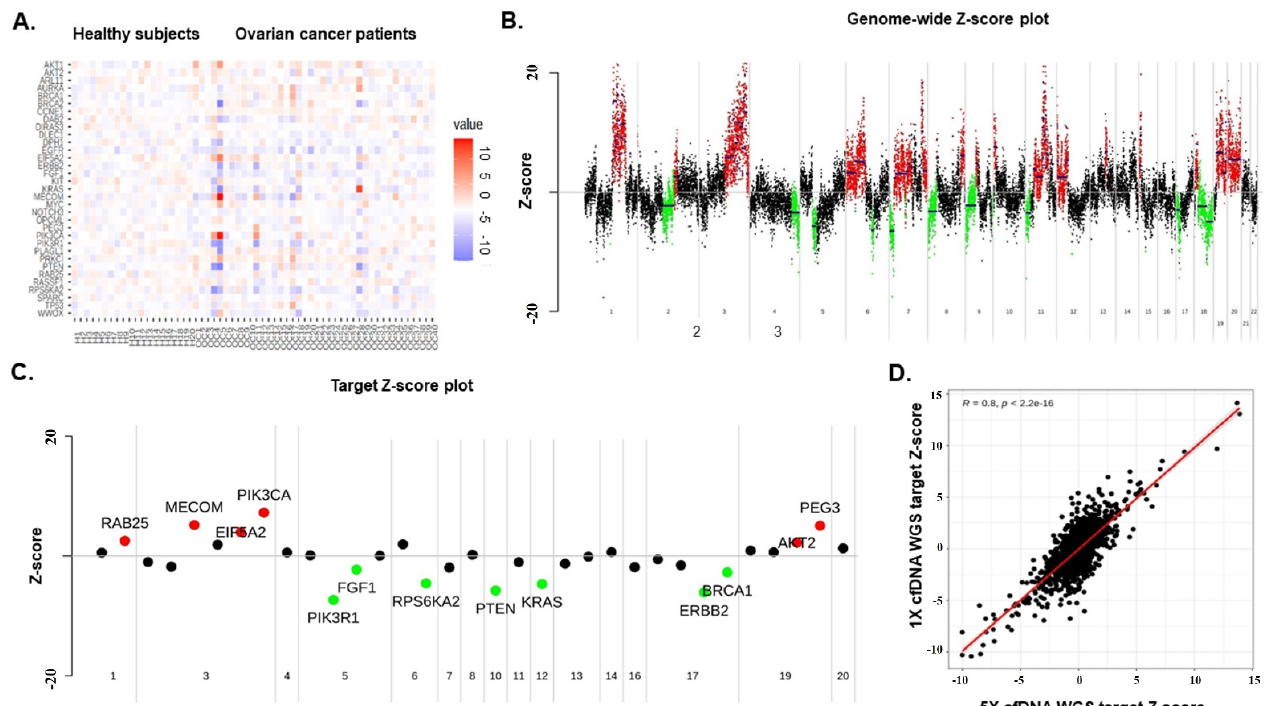
Figure 1. ( A ) The heatmap of the shallow WGS for 40 EOC patients and 20 healthy subjects. Amplified genomic regions are shown in red, and deleted genomic regions are presented in blue. These regions are based on window Z-score calculations. ( B ) Genome-wide scatter plot using the Z-scores (OC11). Scatter plot using the Z-scores with the bins for the segmented genome set to 100,000 bases. Red are the segments with copy gain, and green are those with copy loss. ( C ) Target gene scatter plot using the Z-scores (OC11). Scatter plot using the Z-scores of the target genes for each sample (red circle, Z-score ≥ 2; green circle, Z-score < 2; black circle, other). ( D ) Correlation plot using an in- silico method. Downsampling of the reads of the original data to 1X. The correlation was calculated using the Z-scores of the target genes. 3.3. Genome-Wide Instability by Shallow Whole-Genome Sequencing Characterizes EOC We determined the genome-wide instability in cfDNA using the sum of absolute Z- scores (abs [Z-score]) (Table S6). The genome-wide instability score (Gi score) for the EOC patients was significantly elevated compared to that of the healthy subjects ( p = 0.0007, Wilcoxon test) (Figure 2A). In addition, the median Gi score of the advanced EOC patients (stage III/IV) was significantly higher than the median Gi score of the healthy subjects ( p = 0.000579), whereas the median Gi score of the healthy subjects did not significantly differ from that of the early-stage EOC patients (stage I/II) (Figure 2B). There was a trend to- wards higher Gi scores for advanced-stage EOC patients compared to early-stage patients; however, the difference did not reach statistical significance. However, significant differ- ences were observed between healthy subjects and HGSC ( p = 0.02) (Figure 2C). The Gi score differences were not significant between the no recurrence/progression and recur- rence/progression groups and between the wild-type BRCA1/2 and BRCA1/2 pathogenic variant groups (Figure S1). To demonstrate the specificity of the observed CNVs identified in the cfDNA of EOC patients, we retrieved segmented CN data for ovarian tissue-derived gDNA in the TCGA database. The two datasets were in concordance based on the Z-scores, yielding a Spear- man correlation coefficient of 0.44 ( p = 0.0095) (Figure S2 and Table S7).